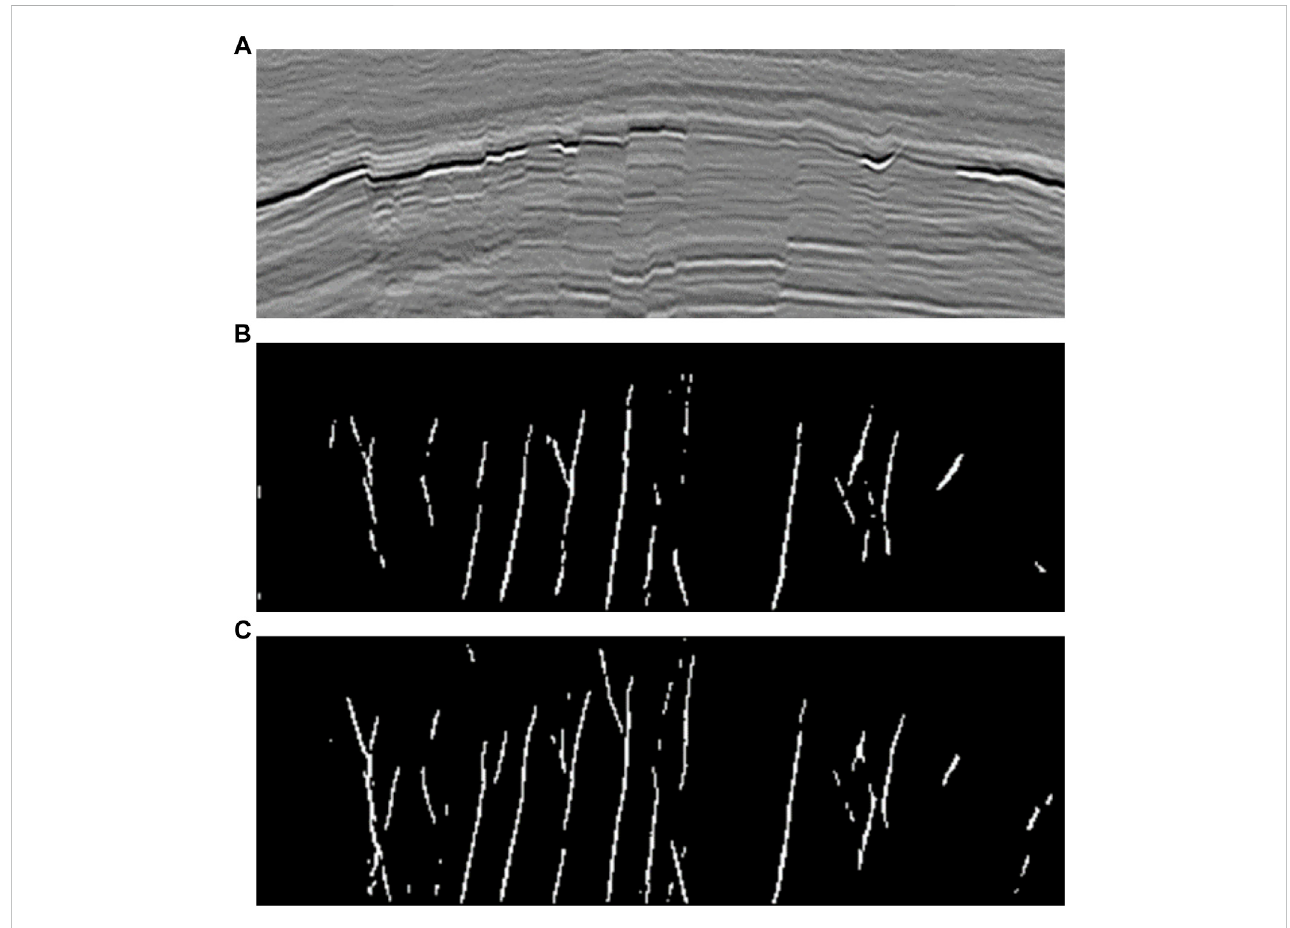
FIGURE 6 Fault (A) identi fi cation results for differentdatasets. there stillmiss a lotof faults and occurs discontinuityidenti fi cation in themiddle and theleftside (B) . In contrast, (C) do batter in the middle of the seismic data pro fi le where the seismic event is not clearly and